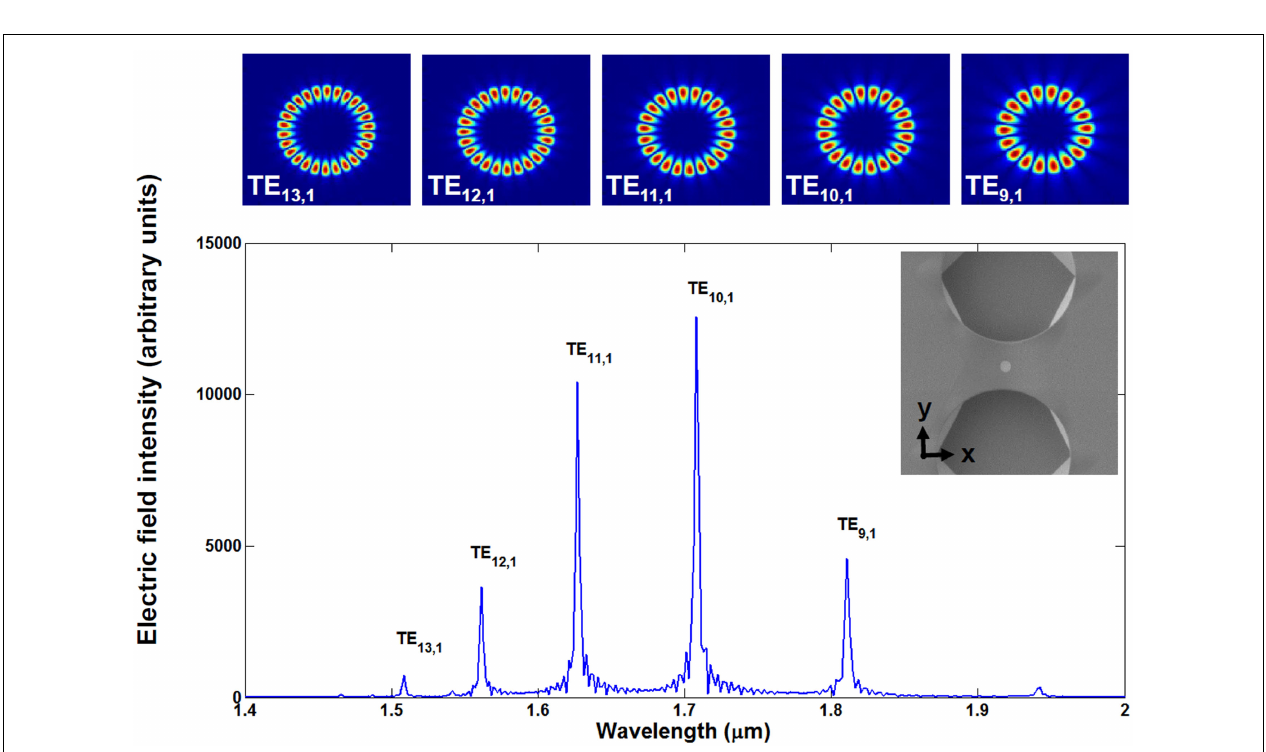
FIGURE 5 | Two-dimensional Raman spectroscopy map of a suspended 3 µ m Ge disk showing: (A) Raman intensity distribution and (B) actual Raman shift across the Ge surface . The black solid and dashed contour lines specify the regions with highest Raman intensity of more than 400 and 350 counts, respectively.